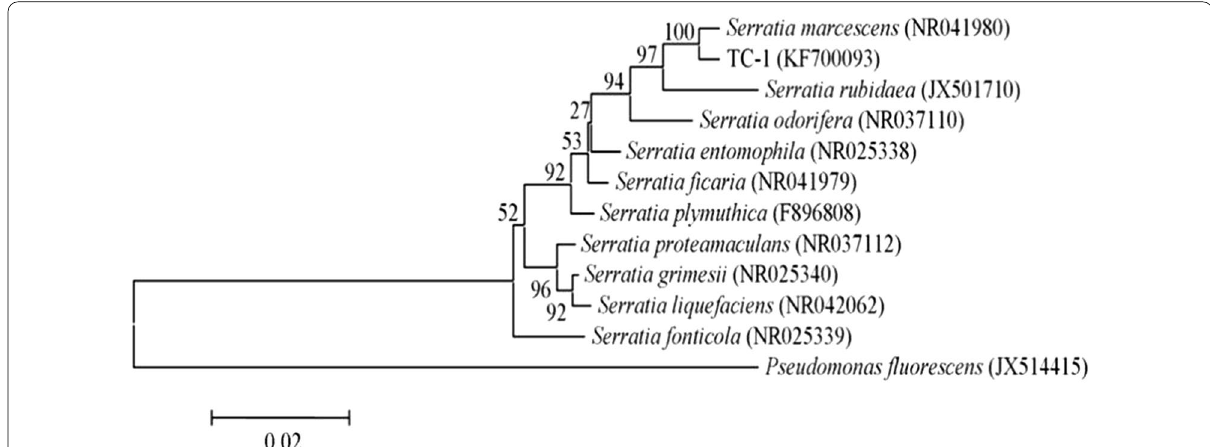
Fig. 2 The MEGA7.0‑constructed Neighbor‑joining phylogenetic tree based on 16S rRNA sequences showing the genetic relationship between strain TC‑1 and other Serratia spp. retrieved from the GenBank database. The numbers in parentheses represent the accession numbers in GenBank. The values (from 1000 replicates) are indicated at the branch nodes as the percentages supported by bootstrap. Pseudomonas fluorescens (JX514415) was used to root the phylogenetic tree. The scale bar represents a genetic distance of 0.02 substitutions per nucleotide